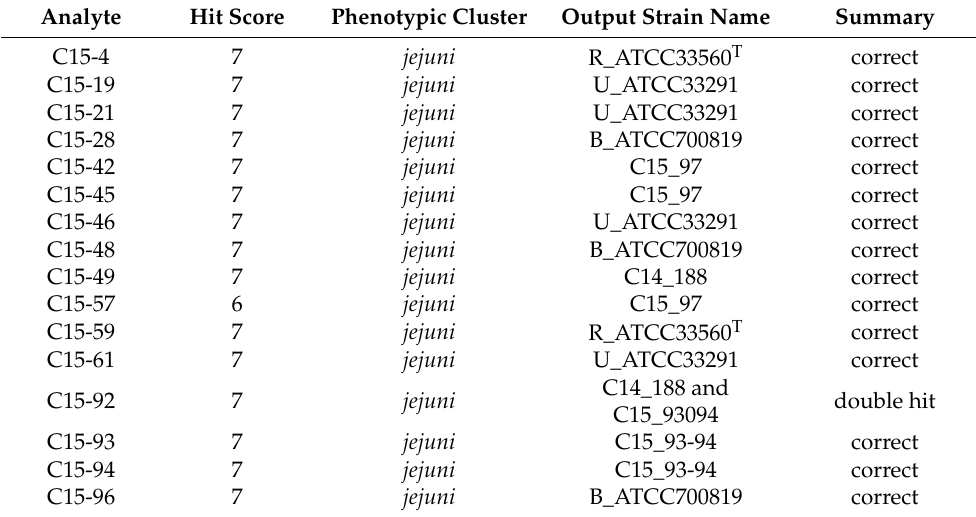
Table 4. Strain Solution ver. 2 analysis